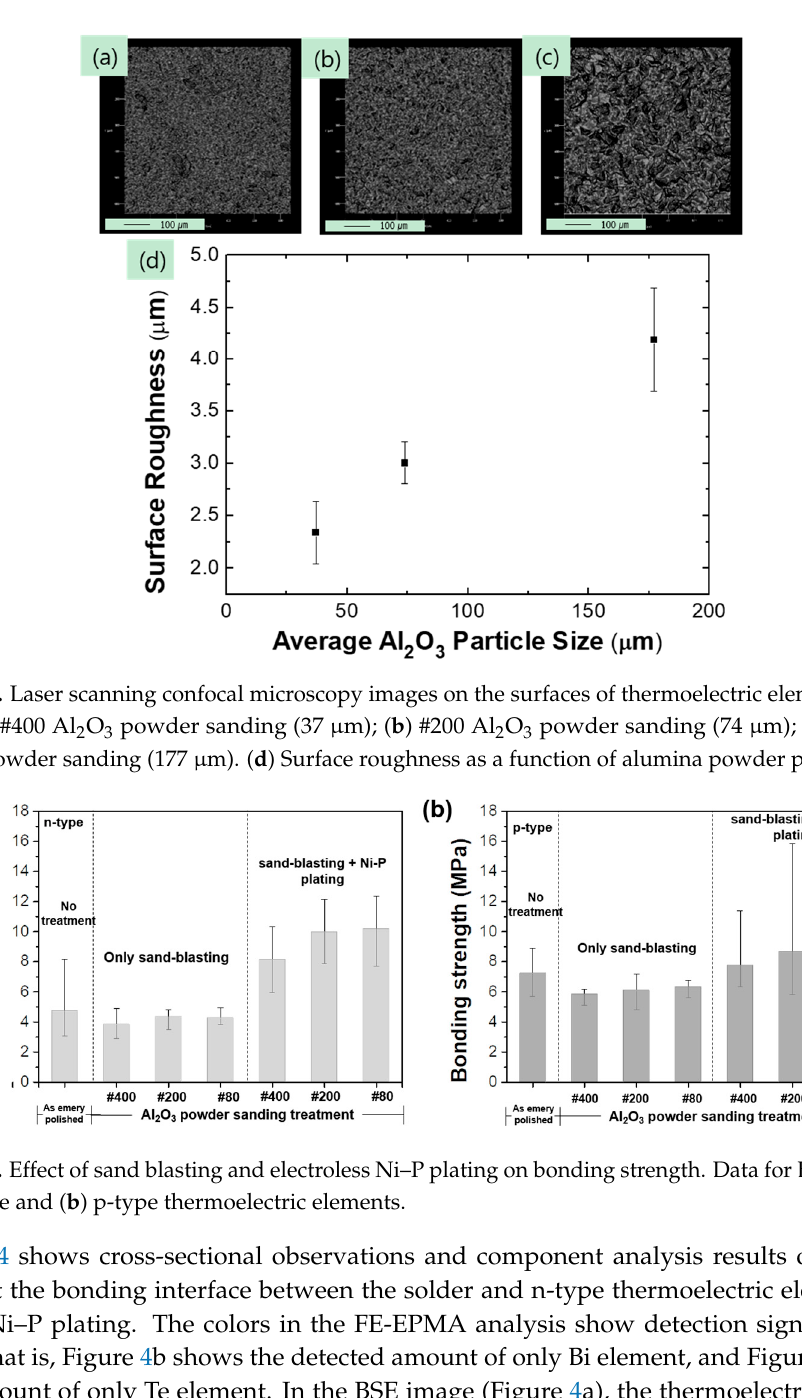
Figure 2. Laser scanning confocal microscopy images on the surfaces of thermoelectric element blocks after ( a ) #400 Al 2 O 3 powder sanding (37 µm); ( b ) #200 Al 2 O 3 powder sanding (74 µm); and ( c ) #80 Al 2 O 3 powder sanding (177 µm). ( d ) Surface roughness as a function of alumina powder particle size.